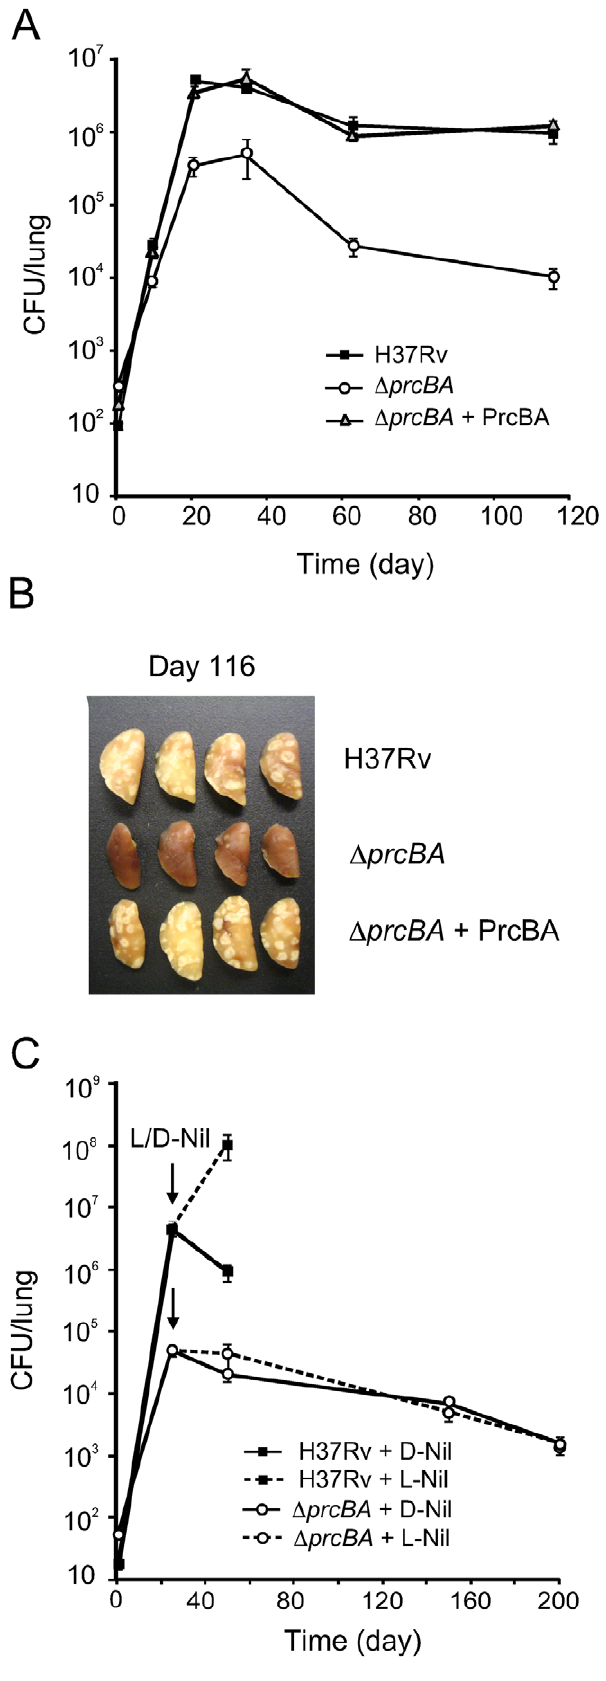
Figure 2. The proteasome is required for optimal growth and persistence in mice. ( A ) Bacterial titers in lungs of C57BL/6 mice infected by aerosol with H37Rv, D prcBA and the complemented mutant. Data are means 6 s.d. from four mice per time point per group and are representative of three independent experiments. ( B ) Gross pathology of lungs infected with H37Rv, D prcBA and complemented mutant at day 116 post-infection. ( C ) Bacterial titers in lungs of C57BL/6 mice infected by aerosol with H37Rv and D prcBA and treated with the iNOS inhibitor L-Nil and its inactive enantiomer D-Nil starting at day 25 post- infection (indicated by arrow). Data are means 6 s.d. from four mice per time point per group and represent two independent